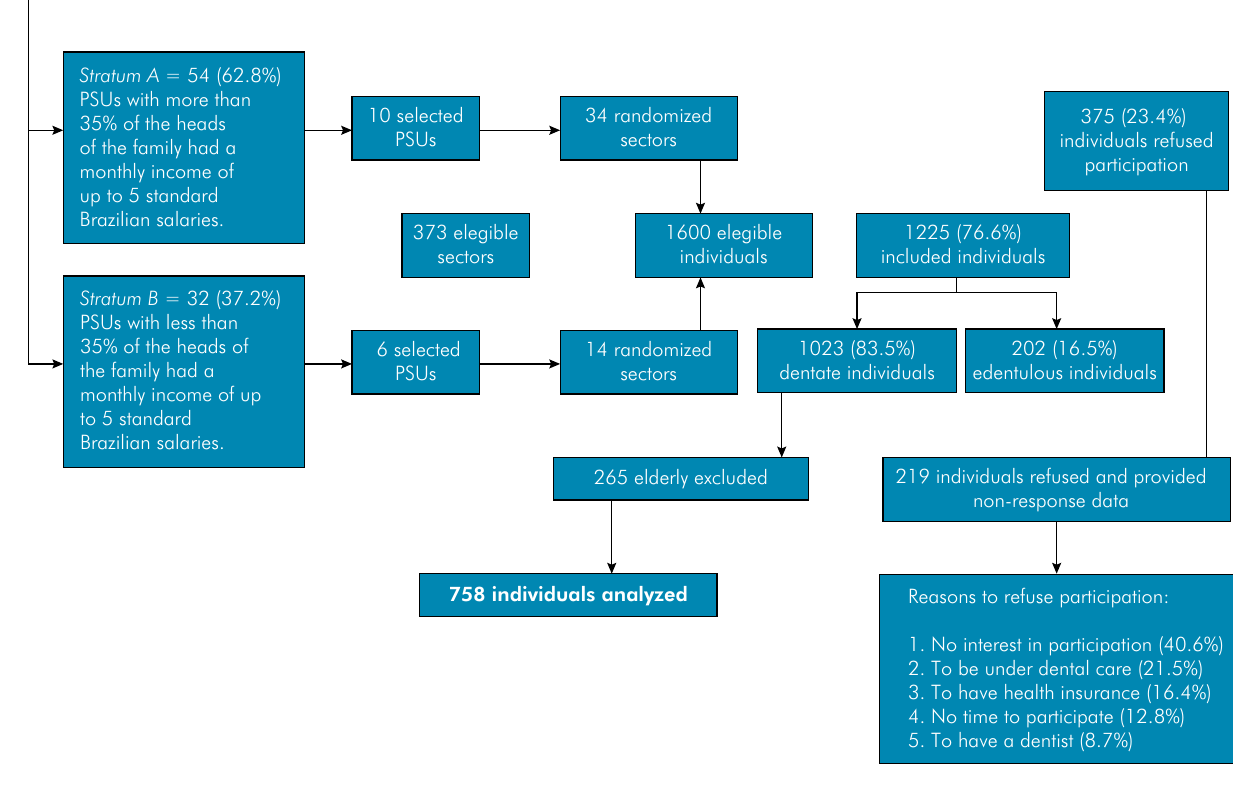
Figure 1. Flowchart of study